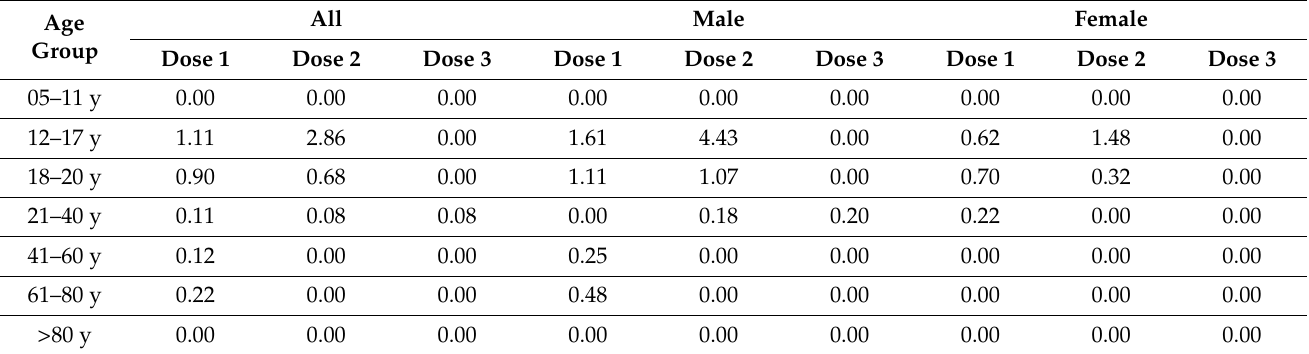
Table 3. Number of myocarditis/pericarditis cases (per 100,000 doses administered) for the BNT162b2 vaccine, stratified by age, sex, and dose number ( n =